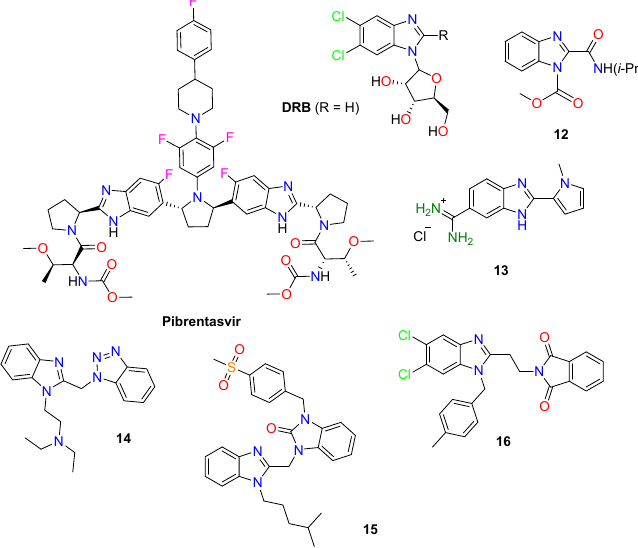
Figure 7. Selected examples of benzimidazole analogs with antiviral activity. The 5,6-dichloro benzimidazole phthalimide derivatives based on an identified lead were prepared and assessed for their anti-hepatitis B virus (HBV) activity. In this series, most of the derivatives proved to be potential HBV inhibitors with high selectivity indices.